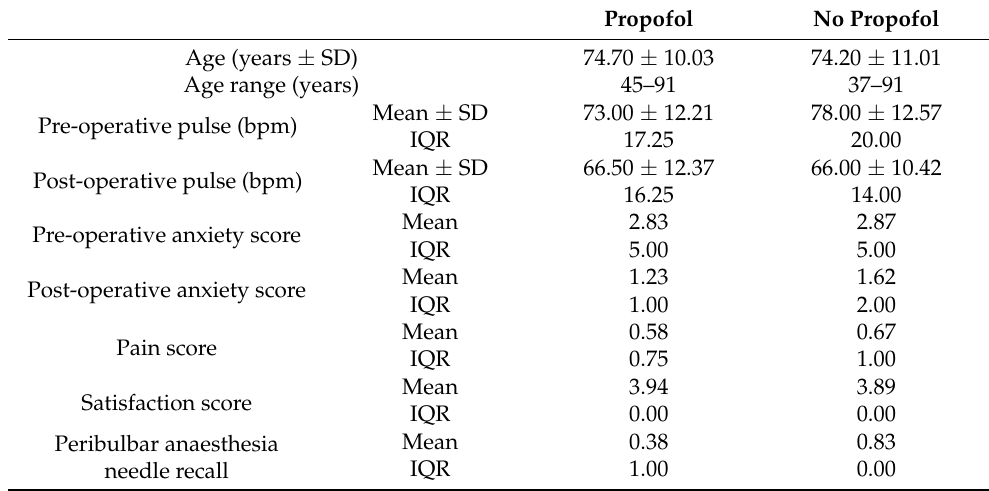
Table 1. Comparative summary of results from both patient